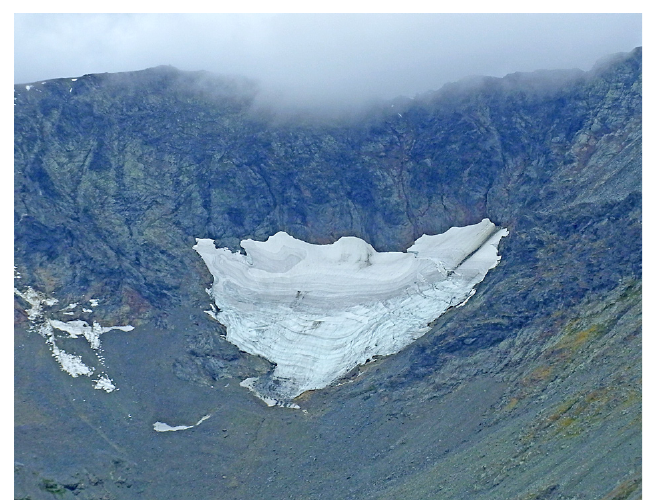
Figure 9: Ekorrglaciären (5) from the south. The lowest point is behind a frontal moraine, which has dammed up a small and recently drained lake. 2010-09-10.